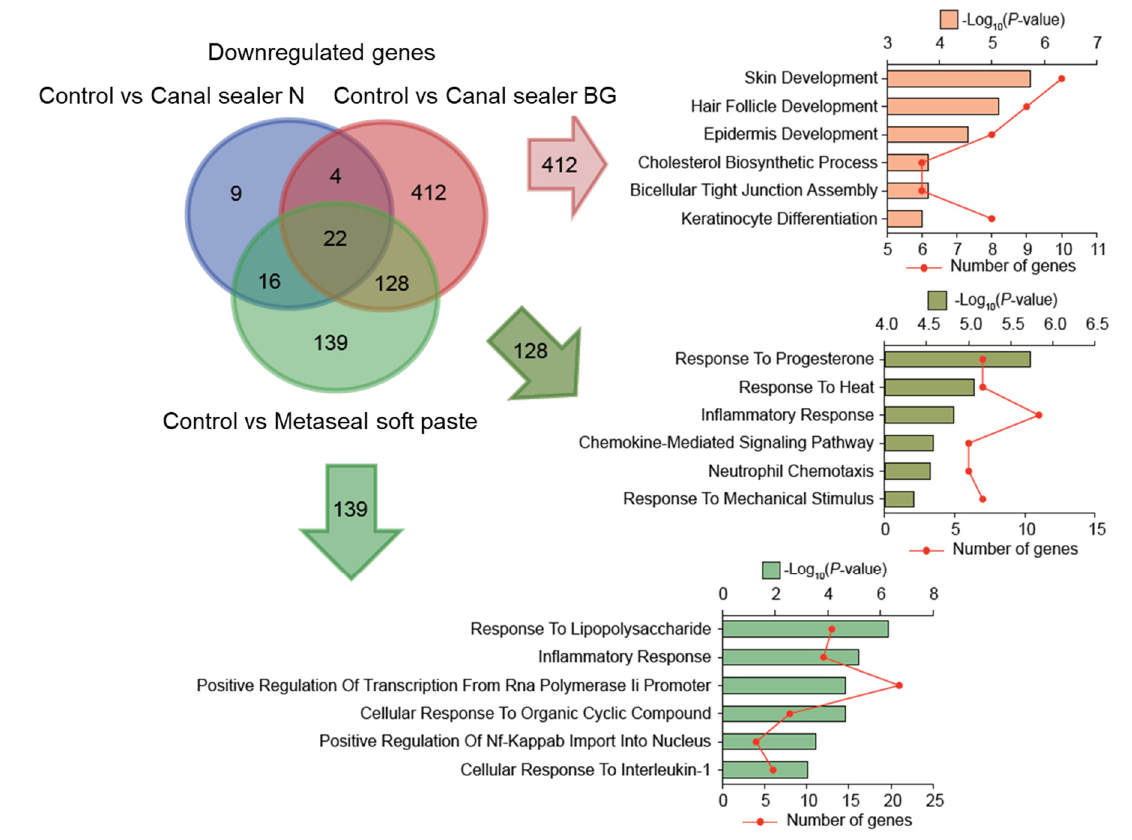
Figure 7. Unique GO terms of differentially downregulated genes in the Canal Sealer BG and Metaseal soft paste groups.